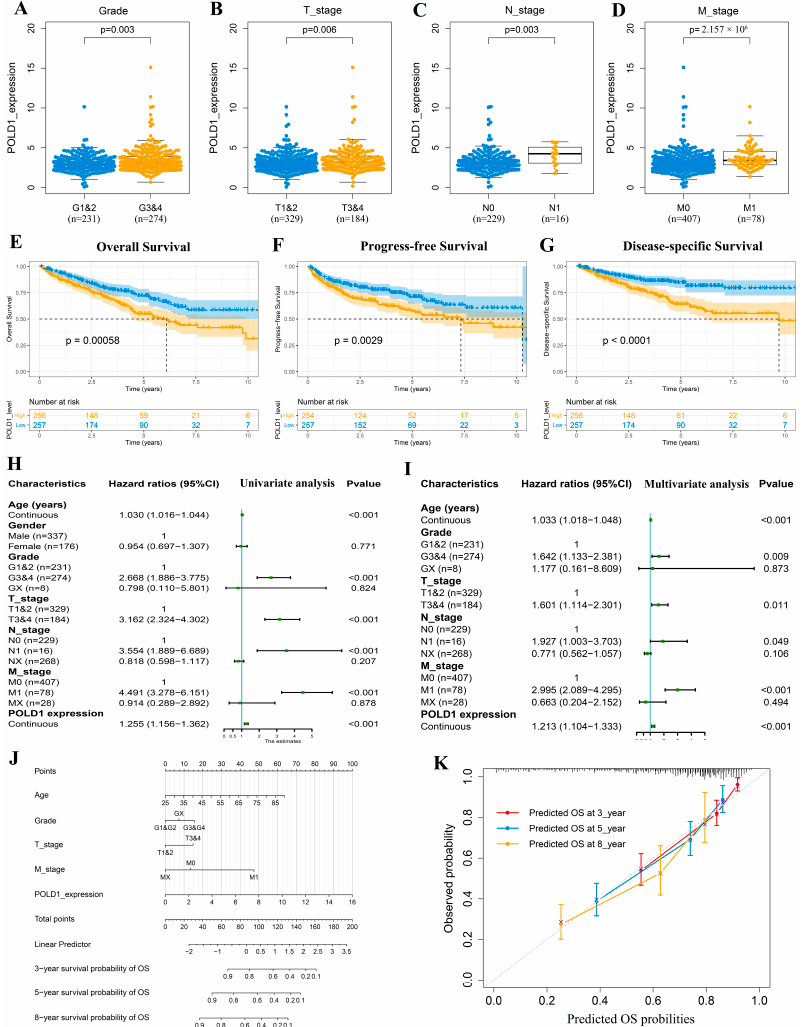
Figure 2. Association between POLD1 expression and the clinical parameters of ccRCC patients and its prognostic significance. ( A – D ) Relationship of POLD1 mRNA levels with individual cancer stages (T stage, N stage and M stage) and tumor grade of ccRCC patients. ( E – G ) Relationship of POLD1 expression levels with overall survival (OS), progression-free survival (PFS), and disease-specific survival (DSS) in the TCGA-KIRC cohort. ( H , I ) Univariate and multivariate survival analyses for selecting prognostic factors. ( J , K ) Establishment ( J ) and estimate ( K ) of the overall survival nomogram for ccRCC patients.